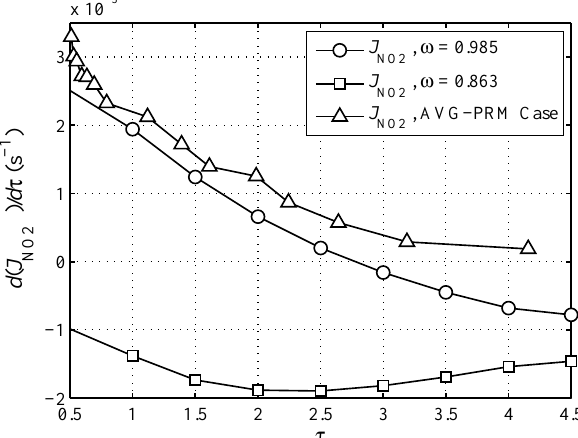
with τ for three cases: ω =0.985 2